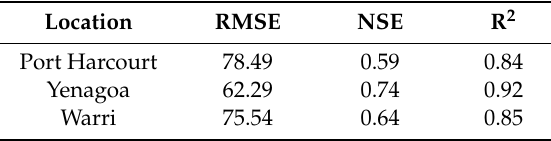
Table 3. Performance assessment of rainfall in the general circulation model (GCM)